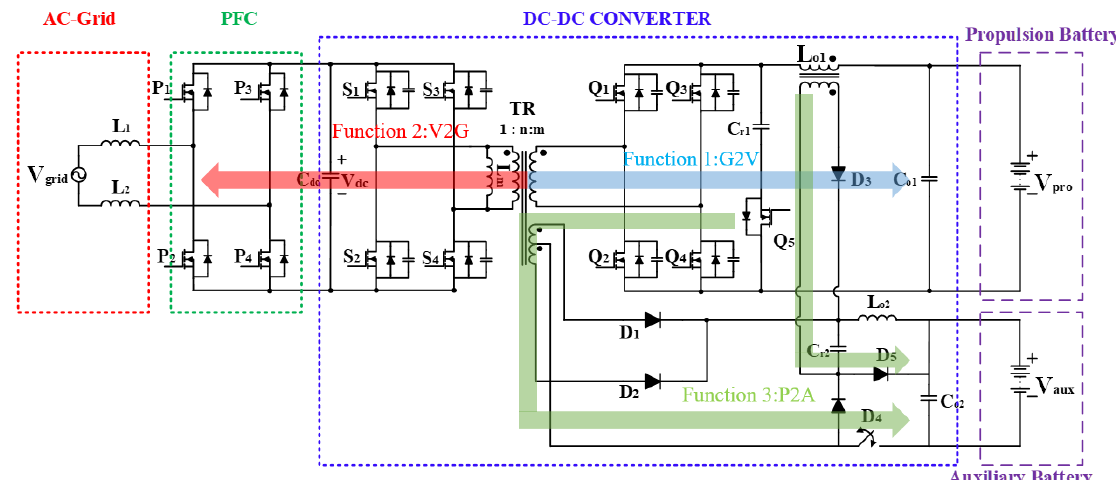
Figure 1. Proposed integrated OBC.